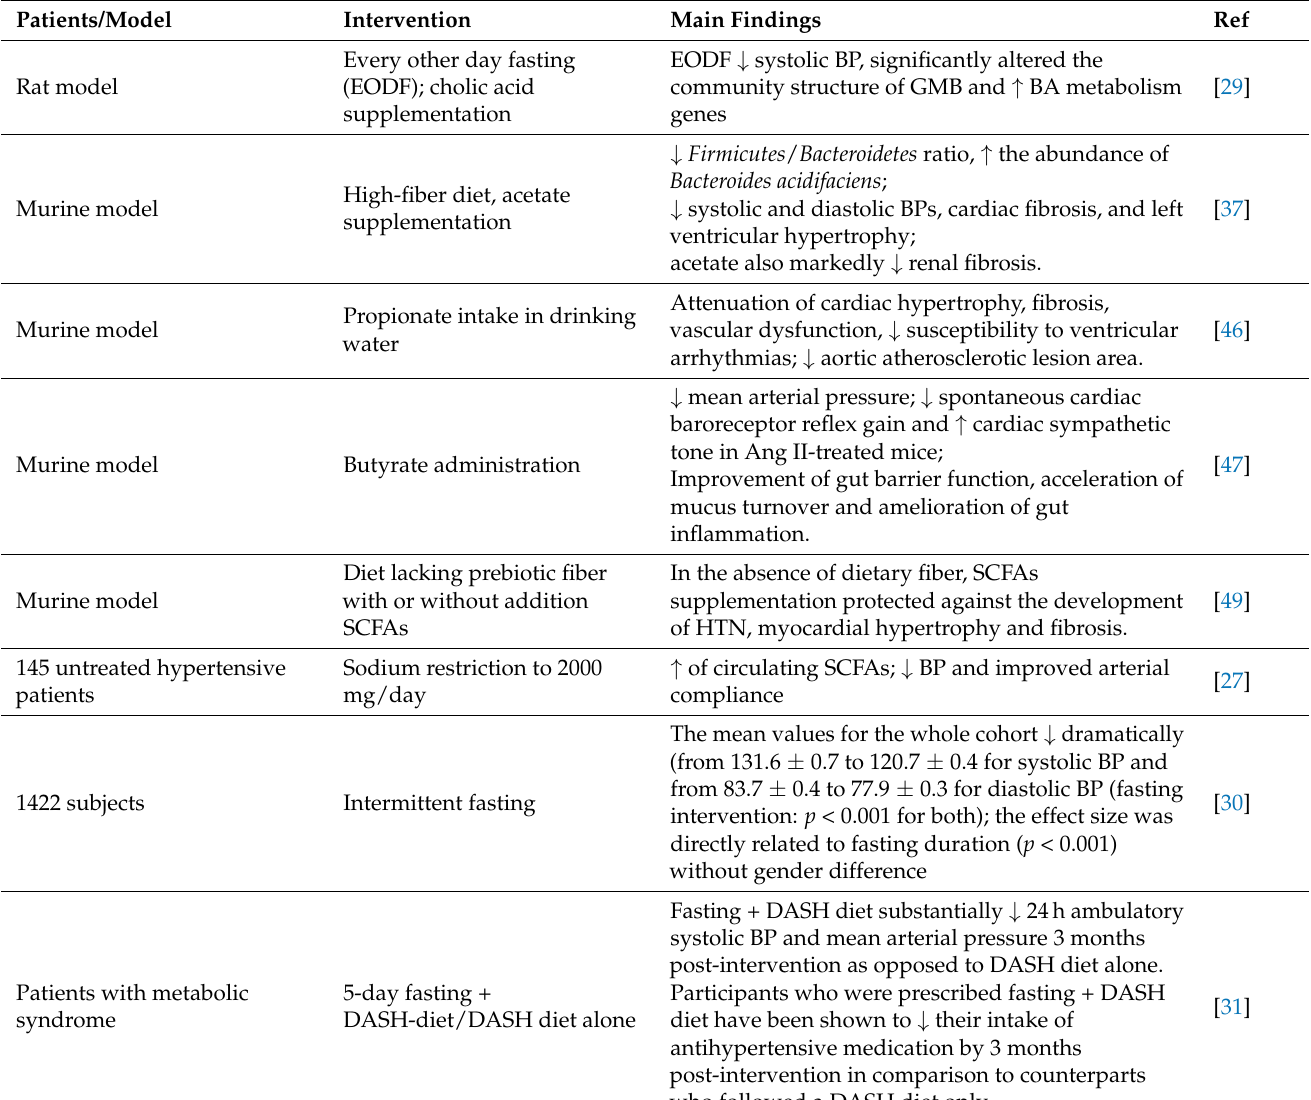
Table 1. The main results of research on targeting gut microbiota and its metabolites in arterial